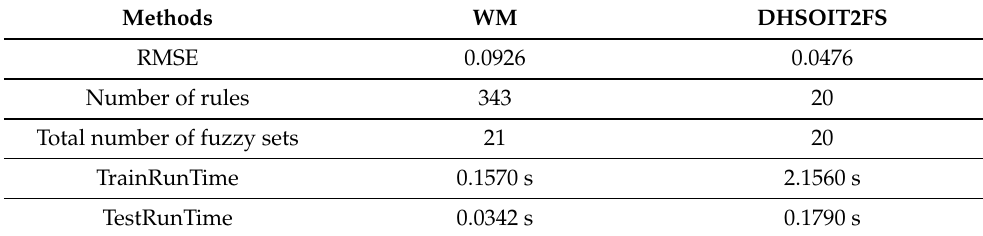
Table 1. Comparison of the results of the two methods in